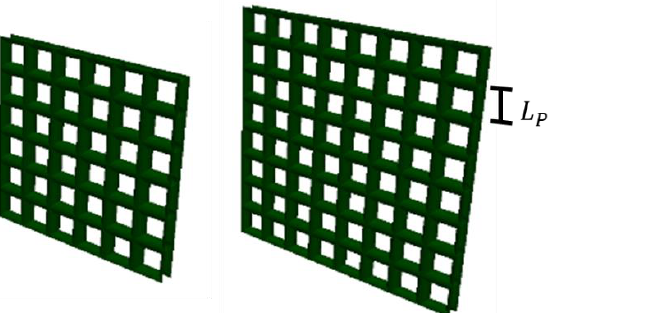
Figure 3. Idealized geometry of two wire mesh screens with different total size and open area ratio ζ = 0.25. Table 2. Geometric properties of the wire mesh screens.